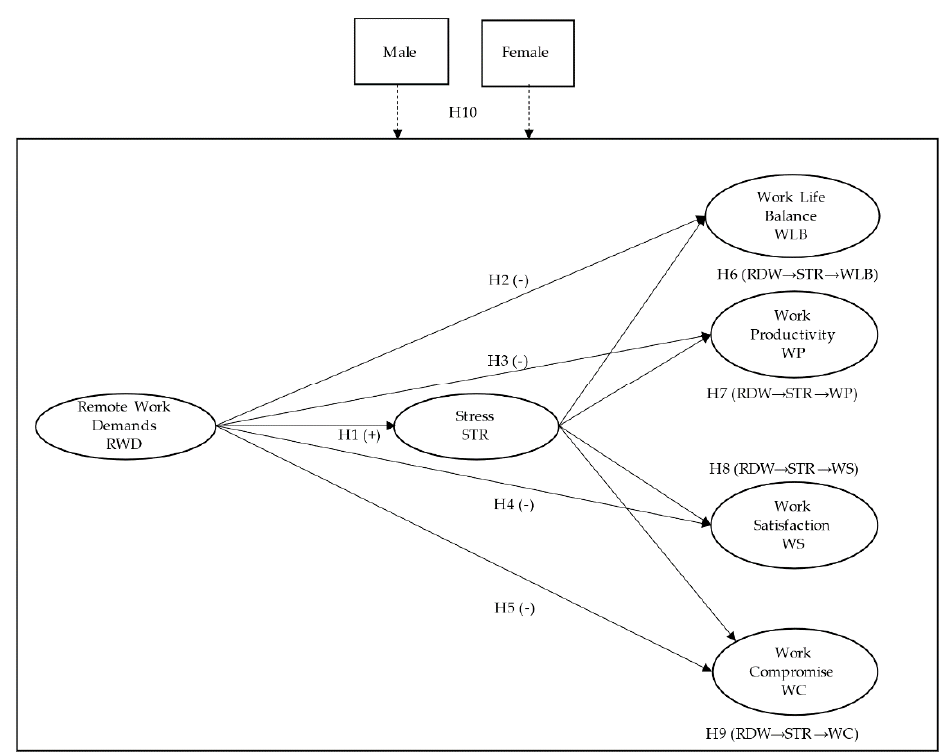
Figure 1. Conceptual Model.